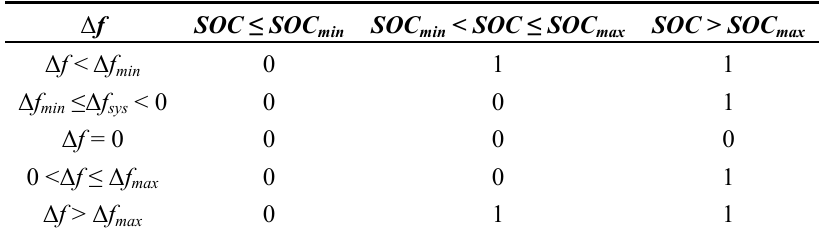
Table 1. Rules of SOC participation